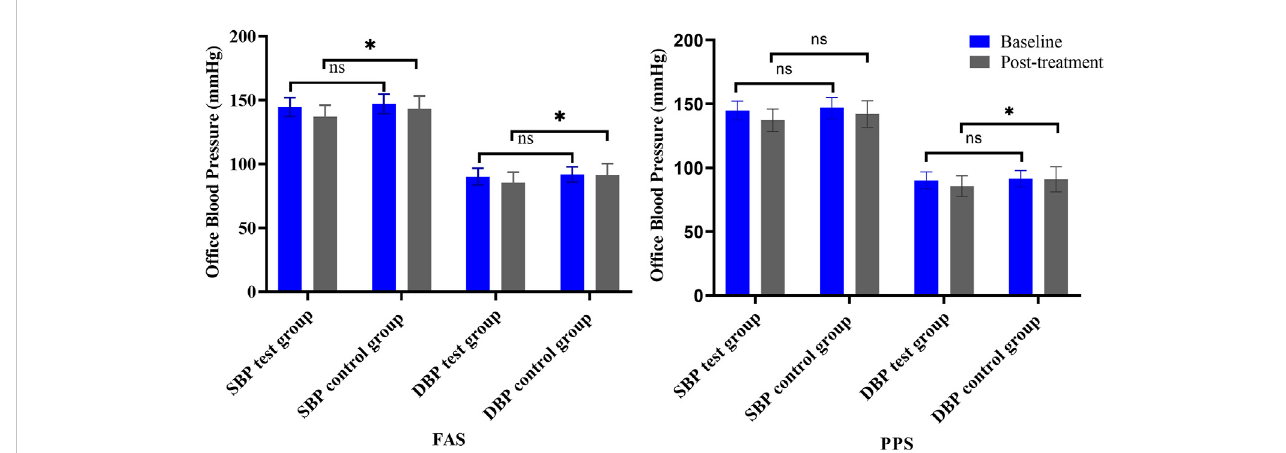
FIGURE 6 Changes in of fi ce BP (left is FAS; right is PPS). Note: ns = non-signi fi cant. *p < .05 versus posttreatment.